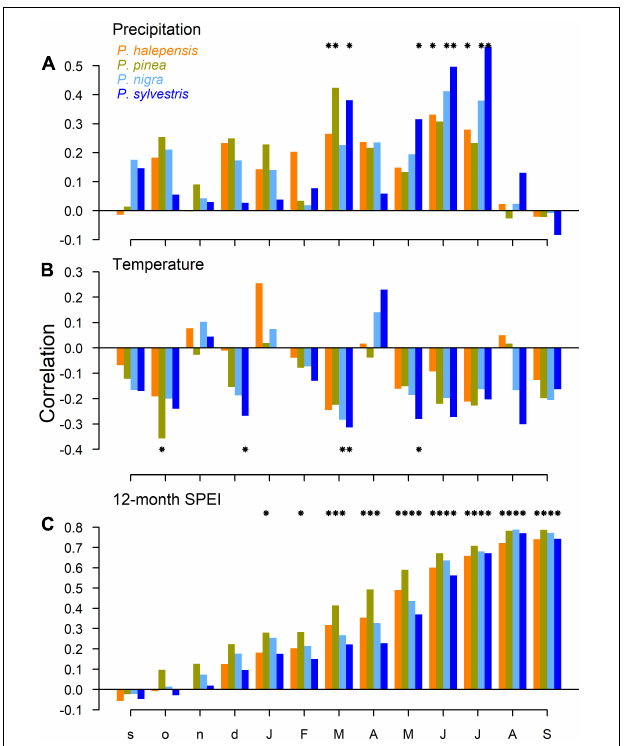
FIGURE 3 | Climate-growth relationships for each species in the period 1980–2017. The correlation coefficient between the residual ring-width chronologies and the (A) precipitation (mm/day), (B) temperature ( ◦ C) and (C) 12-month long SPEI are shown. Asterisks indicate significant ( p < 0.05)